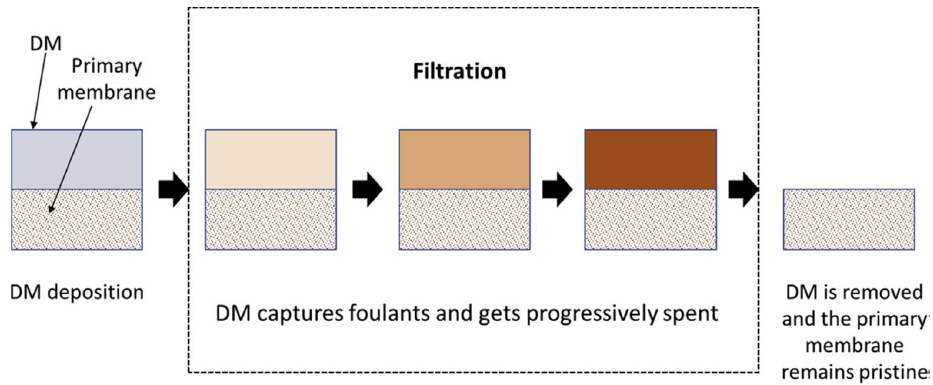
Figure 10. Schematic depicting how DMs reduce fouling, showing DM deposition, DM saturation by foulants, and ultimately DM removal [81]. foulants, and ultimately DM removal